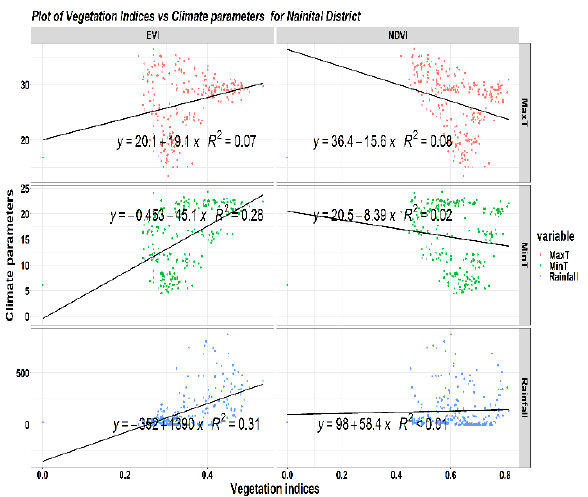
Figure 11 . Scatter Plot between Vegetation Indices and Climate Parameters for Nainital District